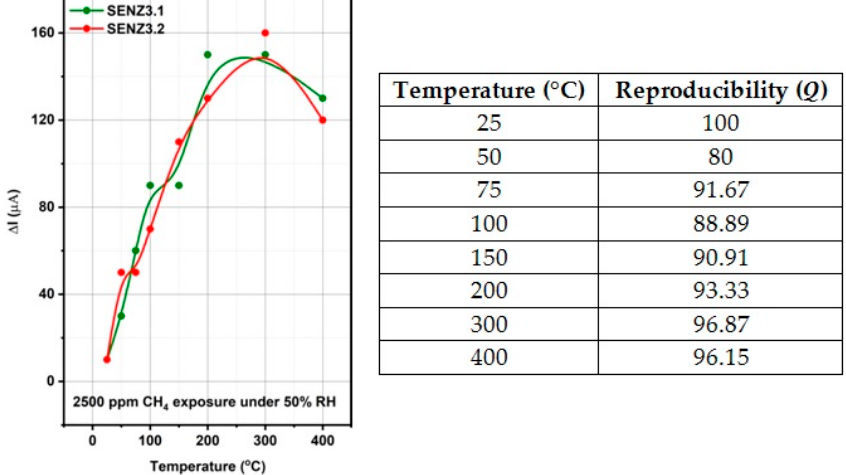
Figure 11. Reproducibility of the conversion effects for catalytic micro-converters of different batches (SENZ 3.1 and SENZ3.2) based on 7Ce3Mn/10LaAl_imp.